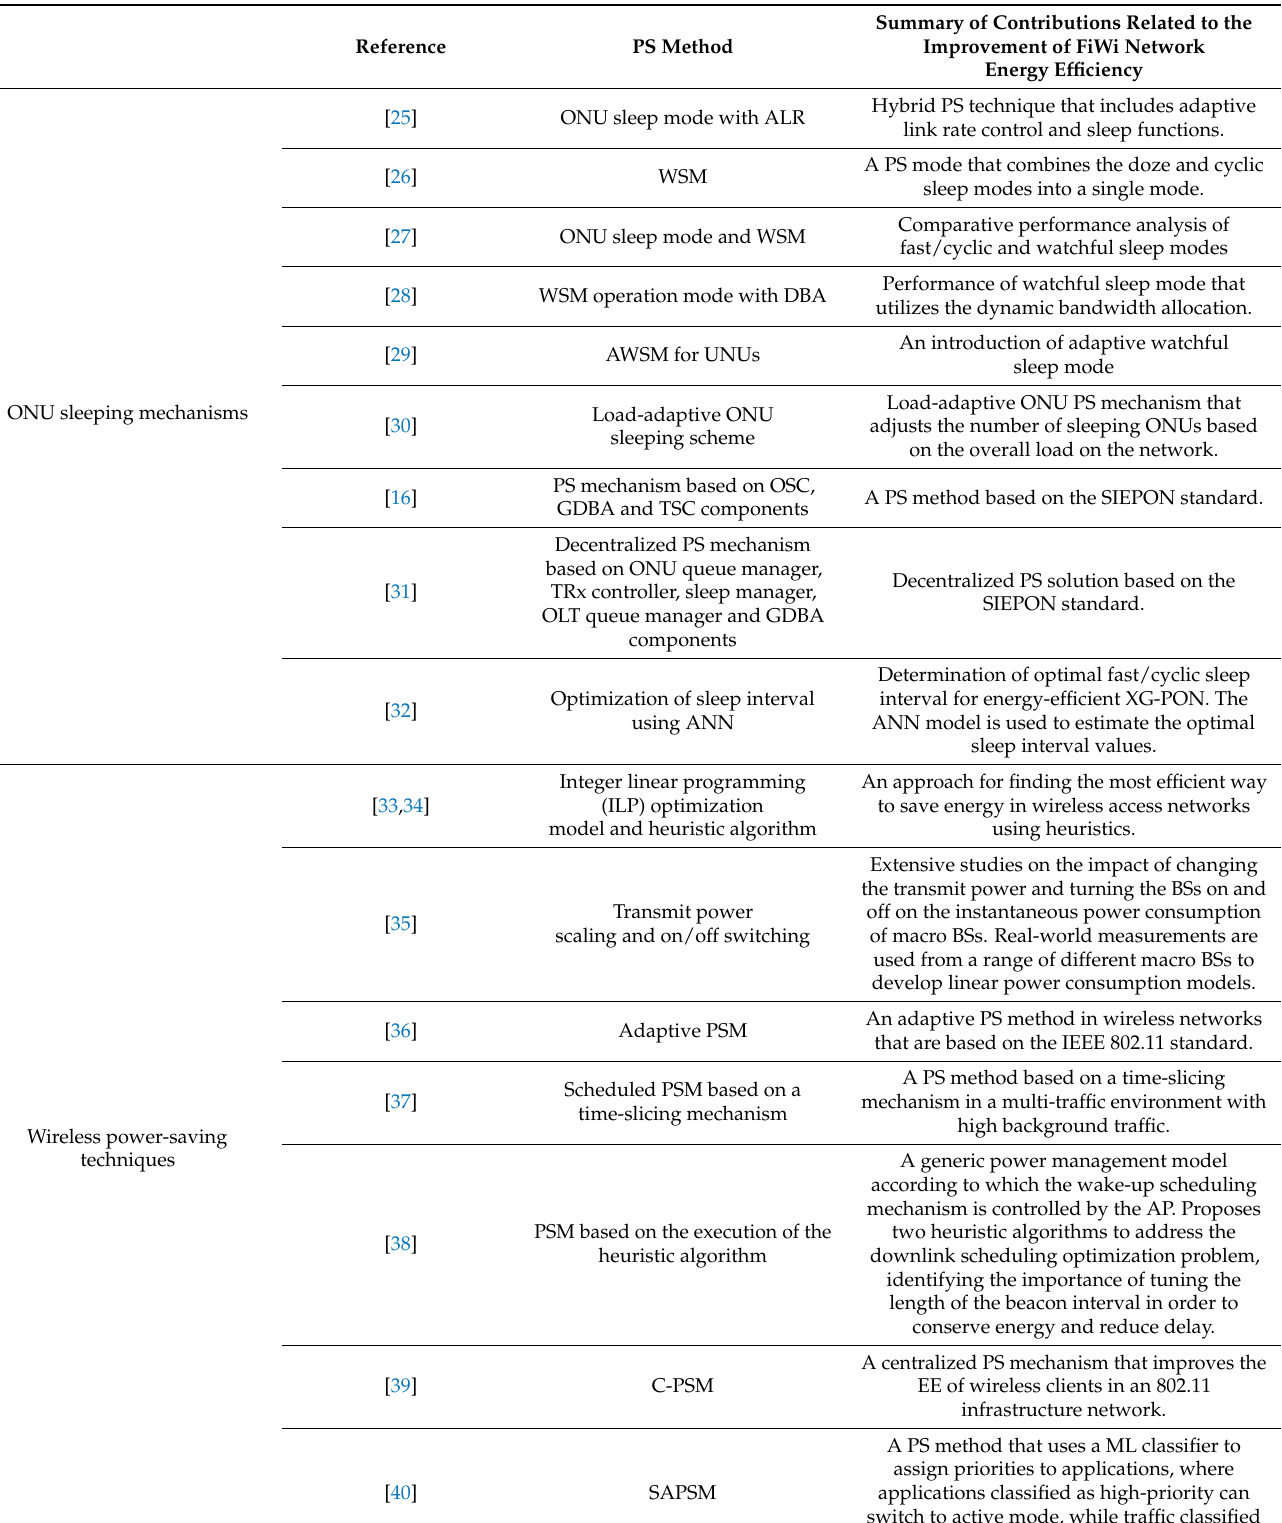
Table 1. Summary of related works on PS methods in R&F